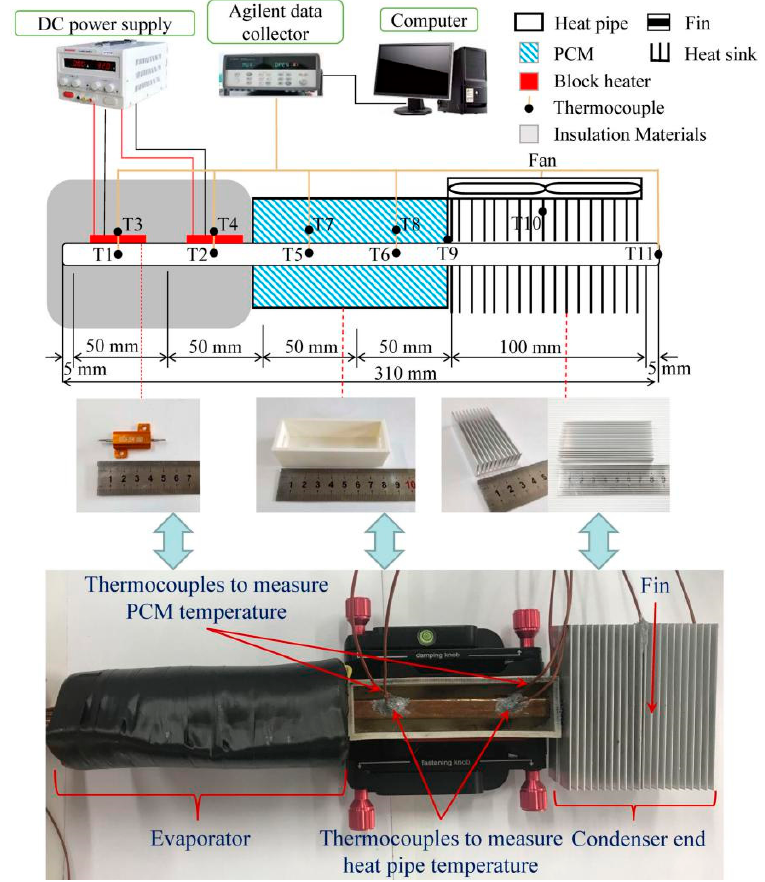
Figure 2. Photos of the testing components and experimental system.